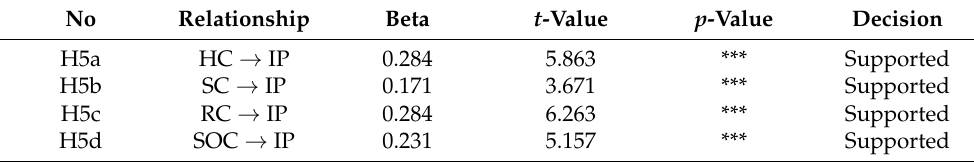
Table 8. Relationship between intellectual capital and innovation